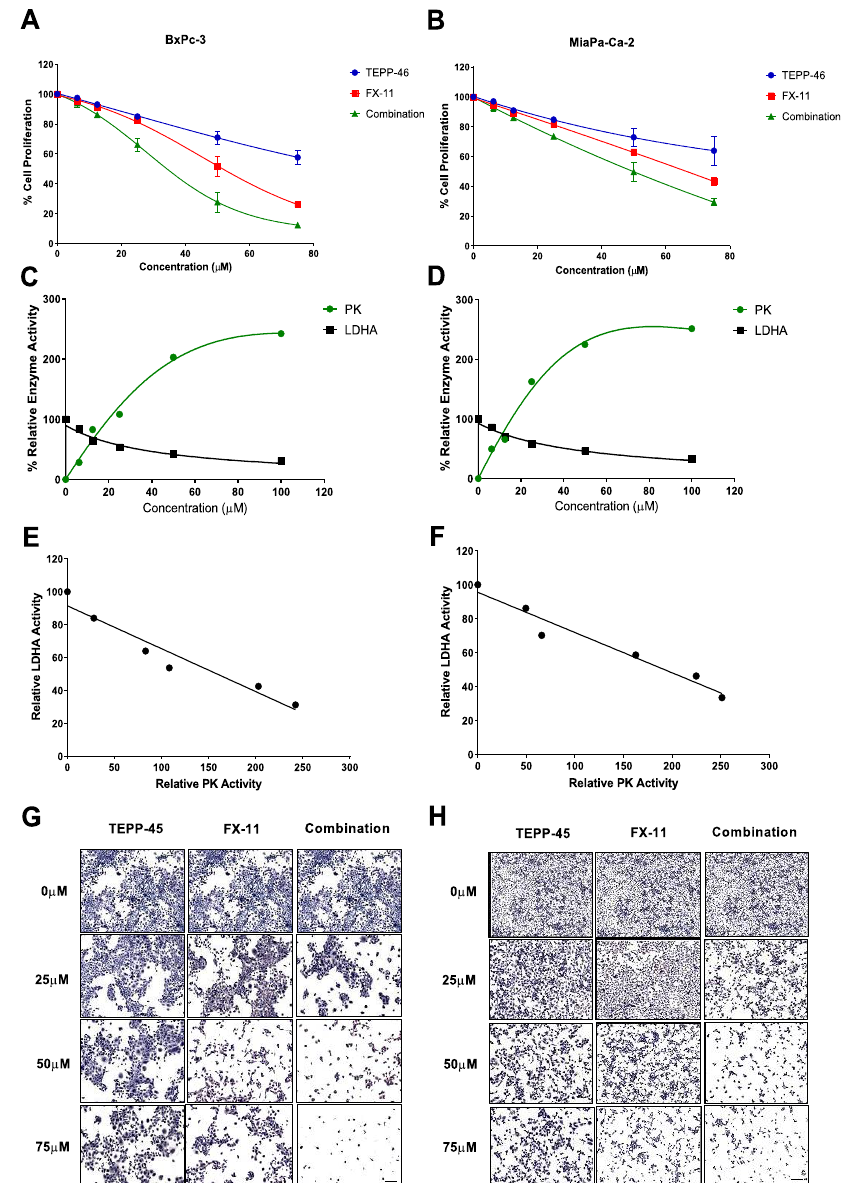
Figure 2. Effect of TEPP-46 and FX-11 on BxPc-3 and MIA PaCa-2 cells. Cell proliferation in